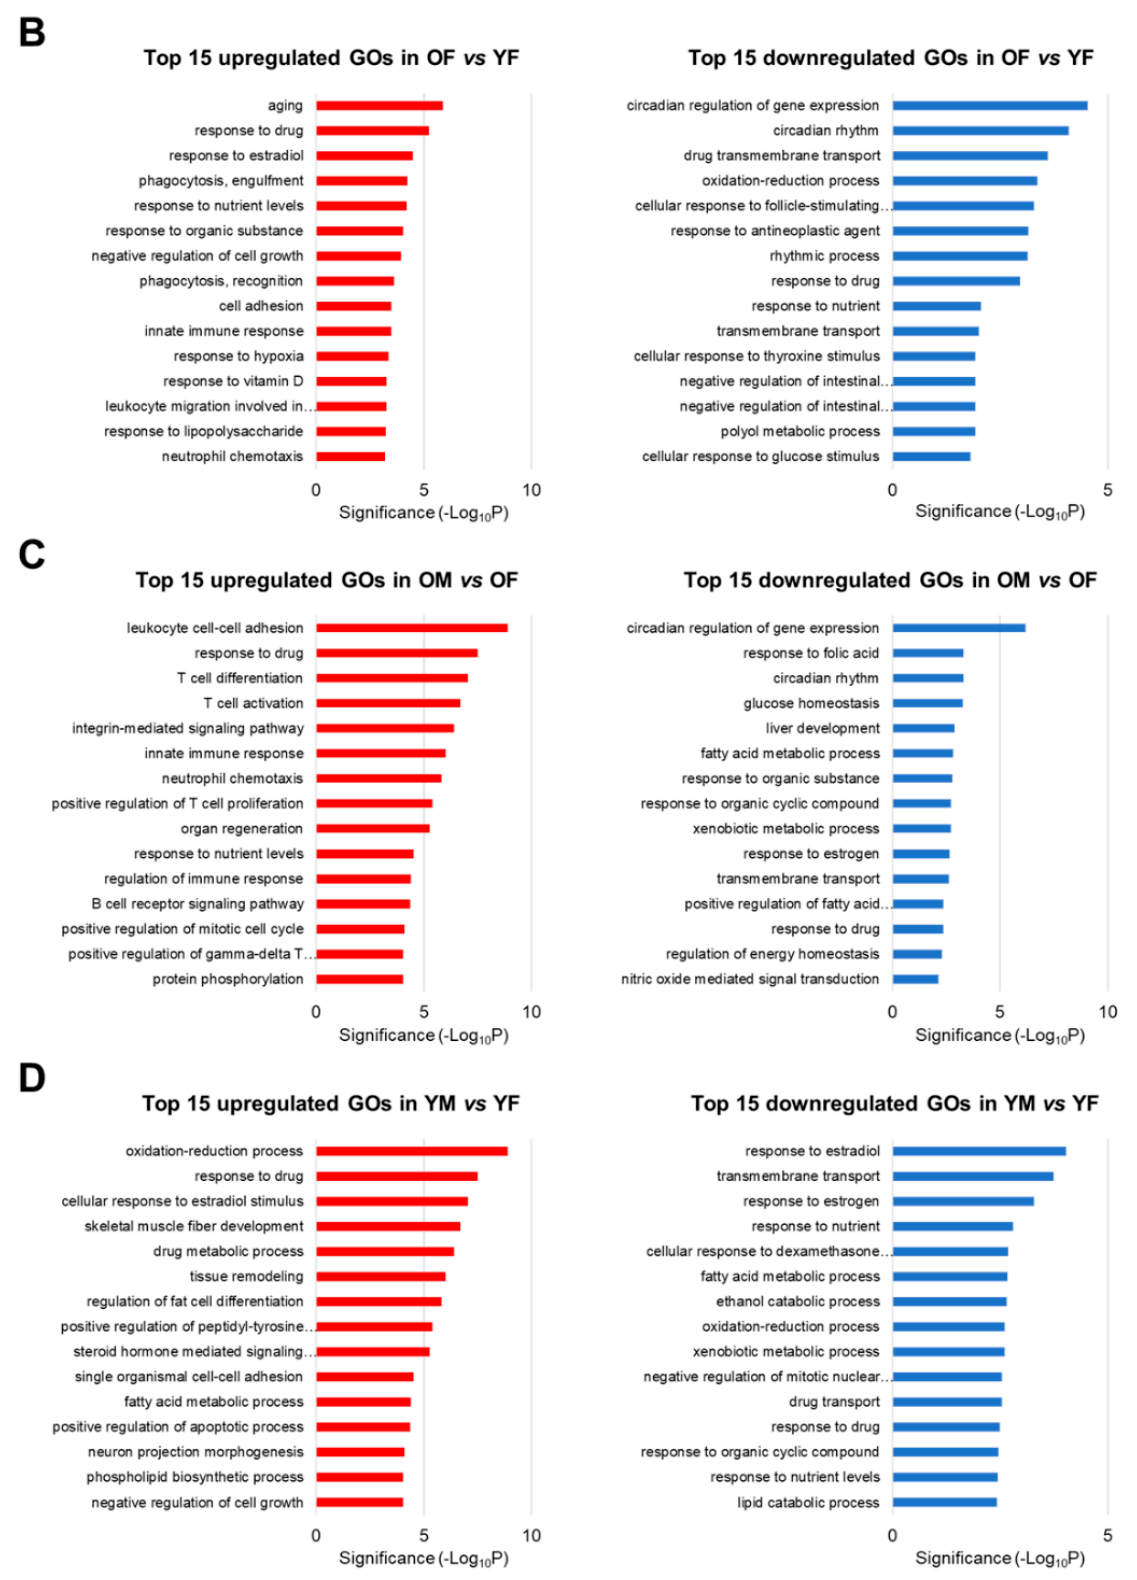
Figure 3. Top 15 Gene Ontology (GO) enrichment analysis of RNA-Seq data of ( A ) OM vs. YM, ( B ) OF vs. YF, ( C ) OM vs. OF, and ( D ) YM vs. YF from SD rats (each n = 3). Upregulated GOs of immune response and downregulated GOs of metabolism and circadian rhythm were detected during aging in both sexes. OM, old male; YM, young male; OF, old female; YF, young female.